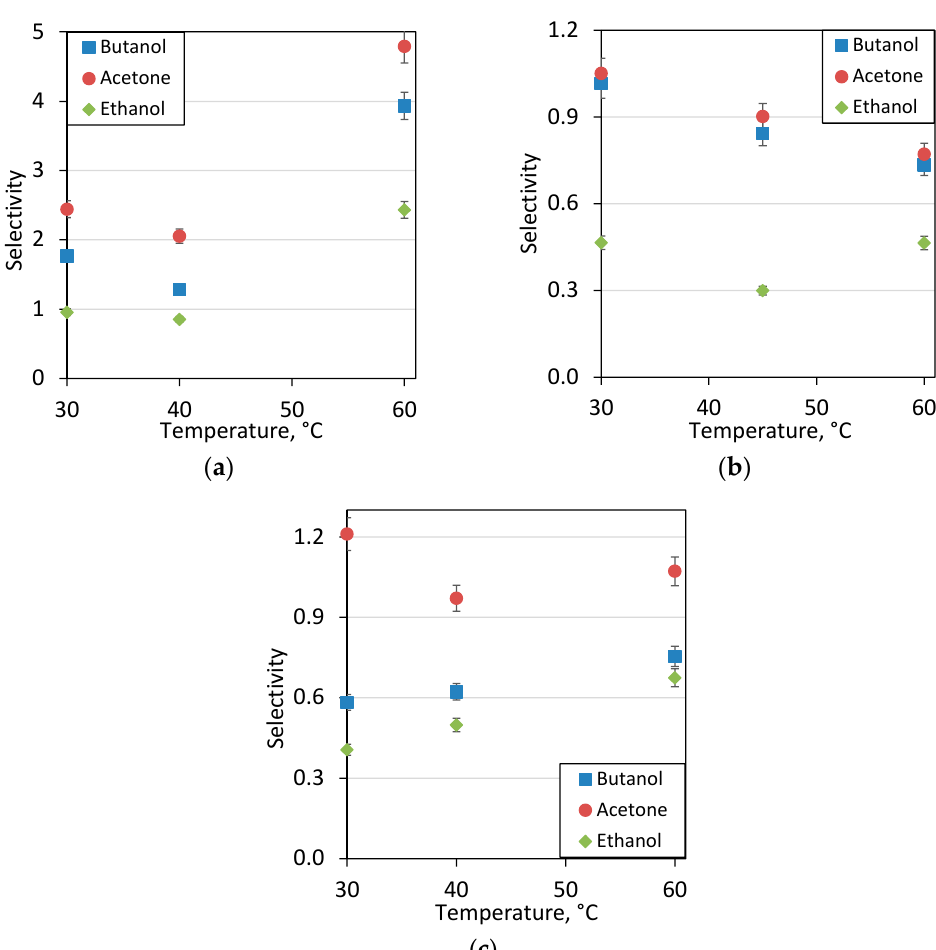
Figure 12. Temperature dependences of selectivity for PHeptMS ( a ), PDecMS ( b ), and MDK-3 ( c ).